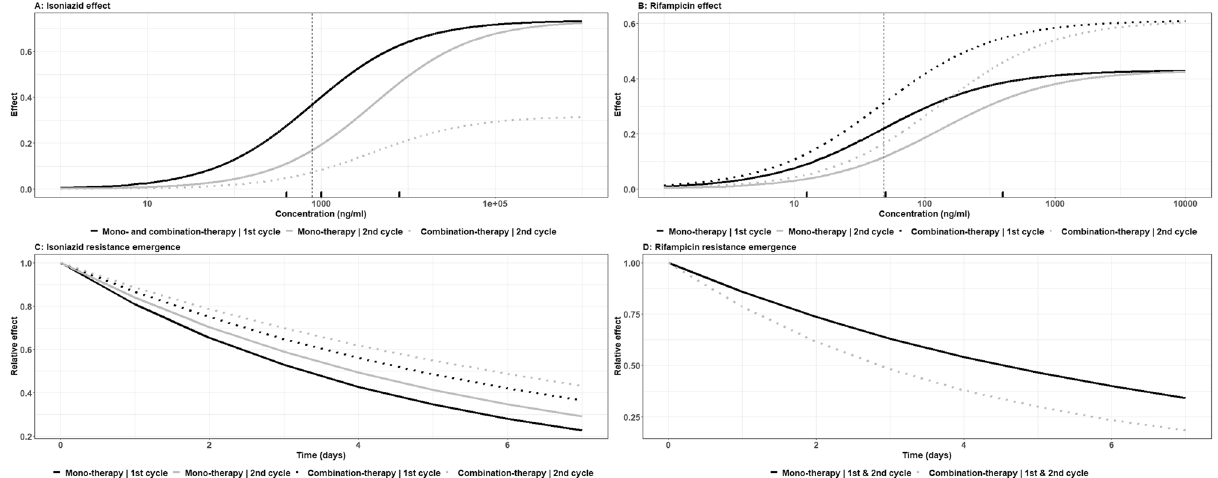
Figure 1. Pharmacodynamic isoniazid-rifampicin interactions. Concentration effect curves for isoniazid ( A ) and rifampicin ( B ) and emergence of resistance for isoniazid ( C ) and rifampicin ( D ). Effect: anti-mycobacterial effect in a static kill curve experiment and relative effect: relative decline of anti-mycobacterial effect over time in a static kill curve experiment proportional to the anti-mycobacterial effect at start of the experiment. The vertical dashed lines in the top panels represent IC 50 ’s for monotherapy during the first evolution cycle with the marginal lines on the x-axis representing the concentrations for the conducted